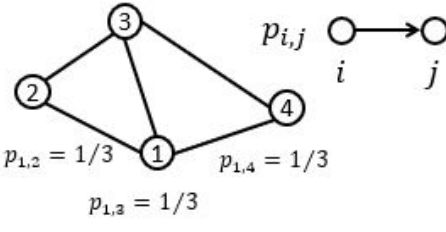
Fig. 1 An example of feature similarity graph.